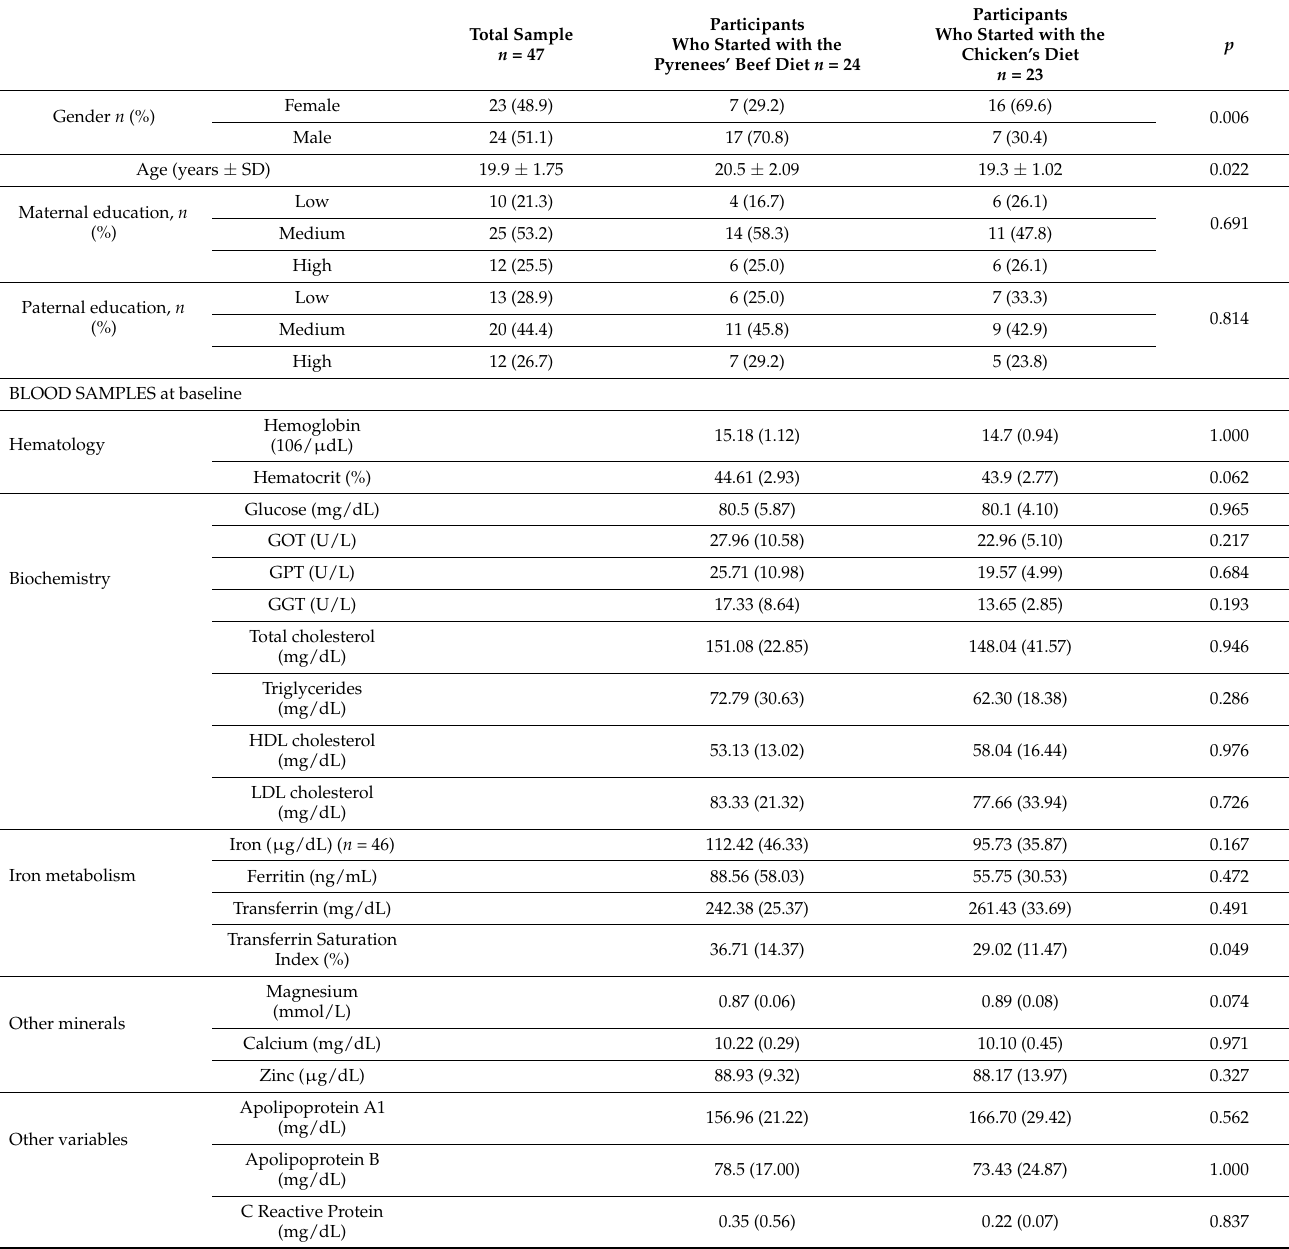
Table 2. Sociodemographic characteristics of included participants at baseline. Total Sample n =